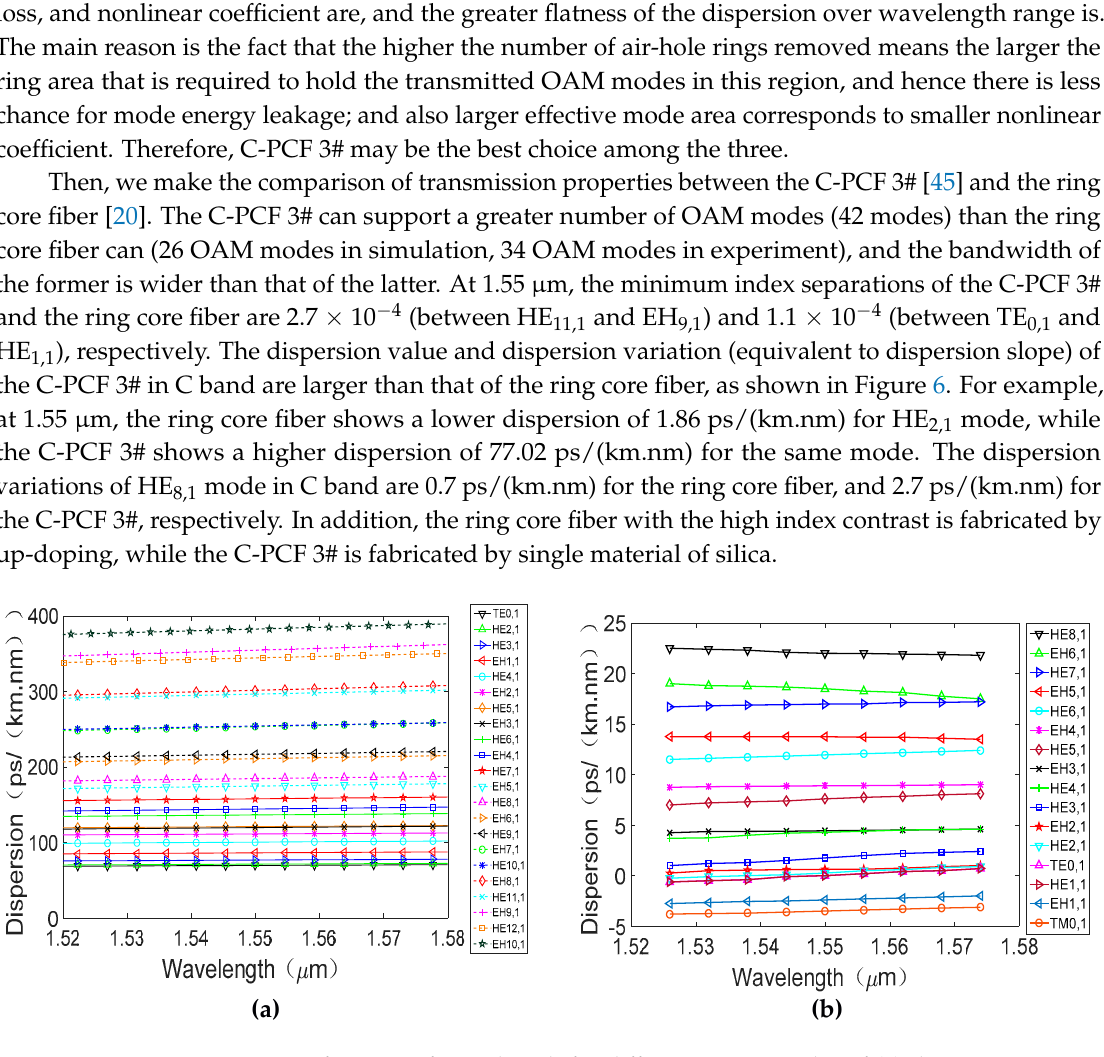
Figure 6. Dispersion as a function of wavelength for different vector modes of ( a ) the C-PCF 3# (reprinted from [45] by permission from Elsevier); ( b ) the air-core ring fiber (reprinted with permission from [20]. Copyright 2014 Optical Society of America).